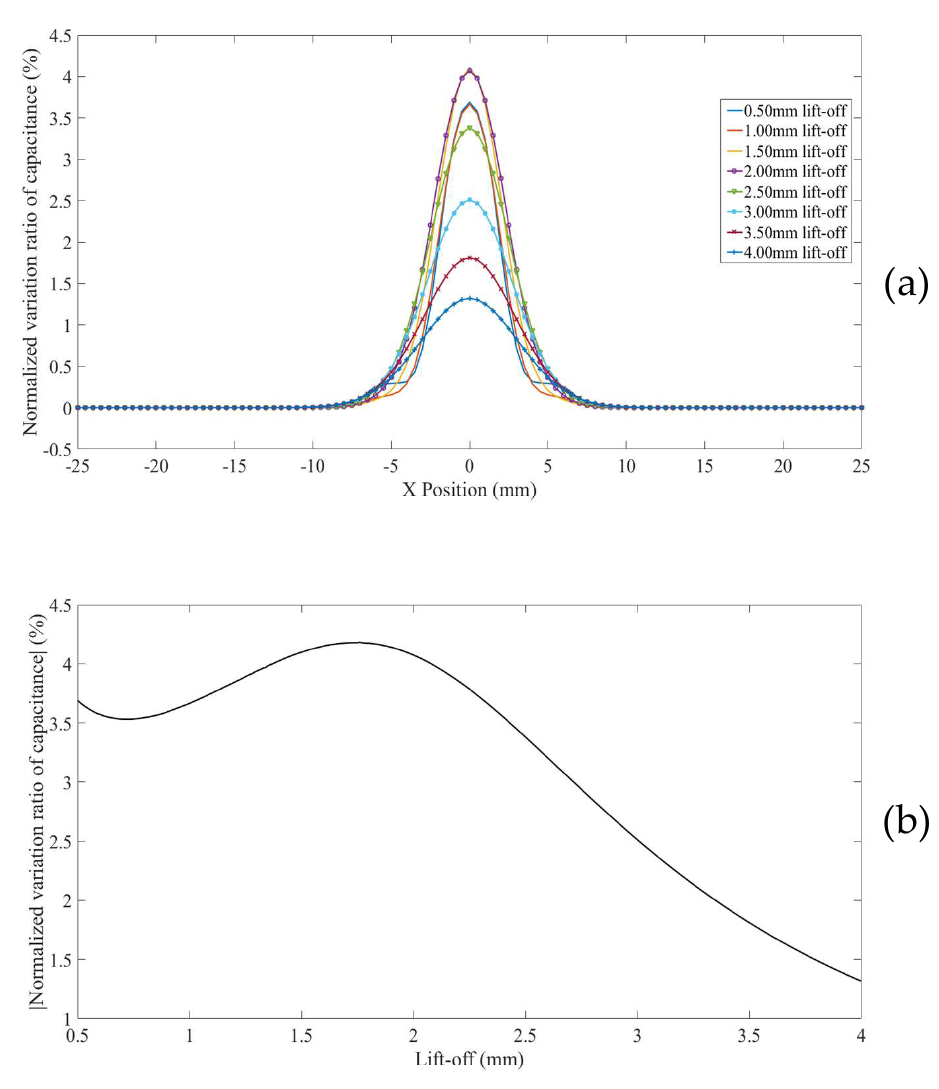
Figure 14. ( a ) NVR curves for Model 8 with lift-offs increased from 0.5 mm to 4 mm and ( b ) absolute values of the NVRs at the centre point against lift-offs.